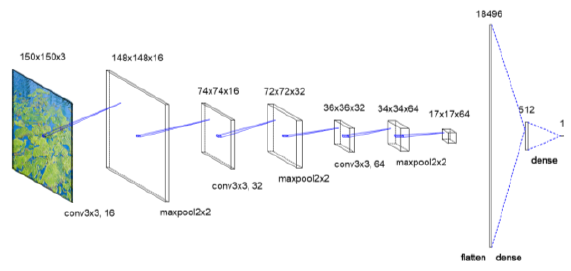
Figure 3. Architecture of the implemented CNN